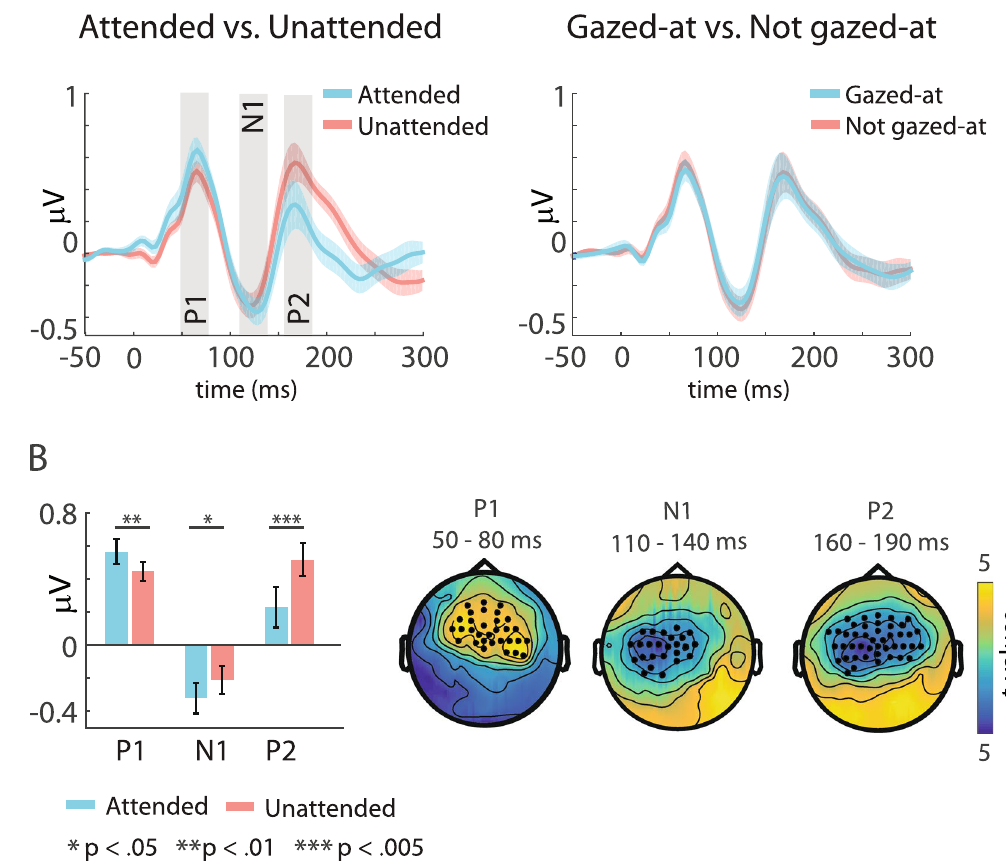
Figure 5. Grand average event-related potentials (ERPs) to standard tones. ( A ) Grand average ERP results using a predefined fronto-central region of interest (ROI) (Fig. 3A). Shown are traces for the Attended (blue colour) versus Unattended (red colour) conditions (left), as well as the Gazed-at (blue colour) versus Not gazed-at (red colour) conditions (right). Shaded ribbons show the standard error of the mean. Significant results for the investigated three time-windows (indicated by grey bars) were found only for the Attended versus Unattended comparison. ( B ) Statistical results for the Attended versus Unattended comparison. Left: Barplot showing the results for the ANOVA using a predefined ROI (Fig. 3A). Right: Topographies showing the results of the cluster-based permutation tests. Significant clusters of channels were found in all three time windows. Colours indicate t-values, black dots indicate channels belonging to the significant